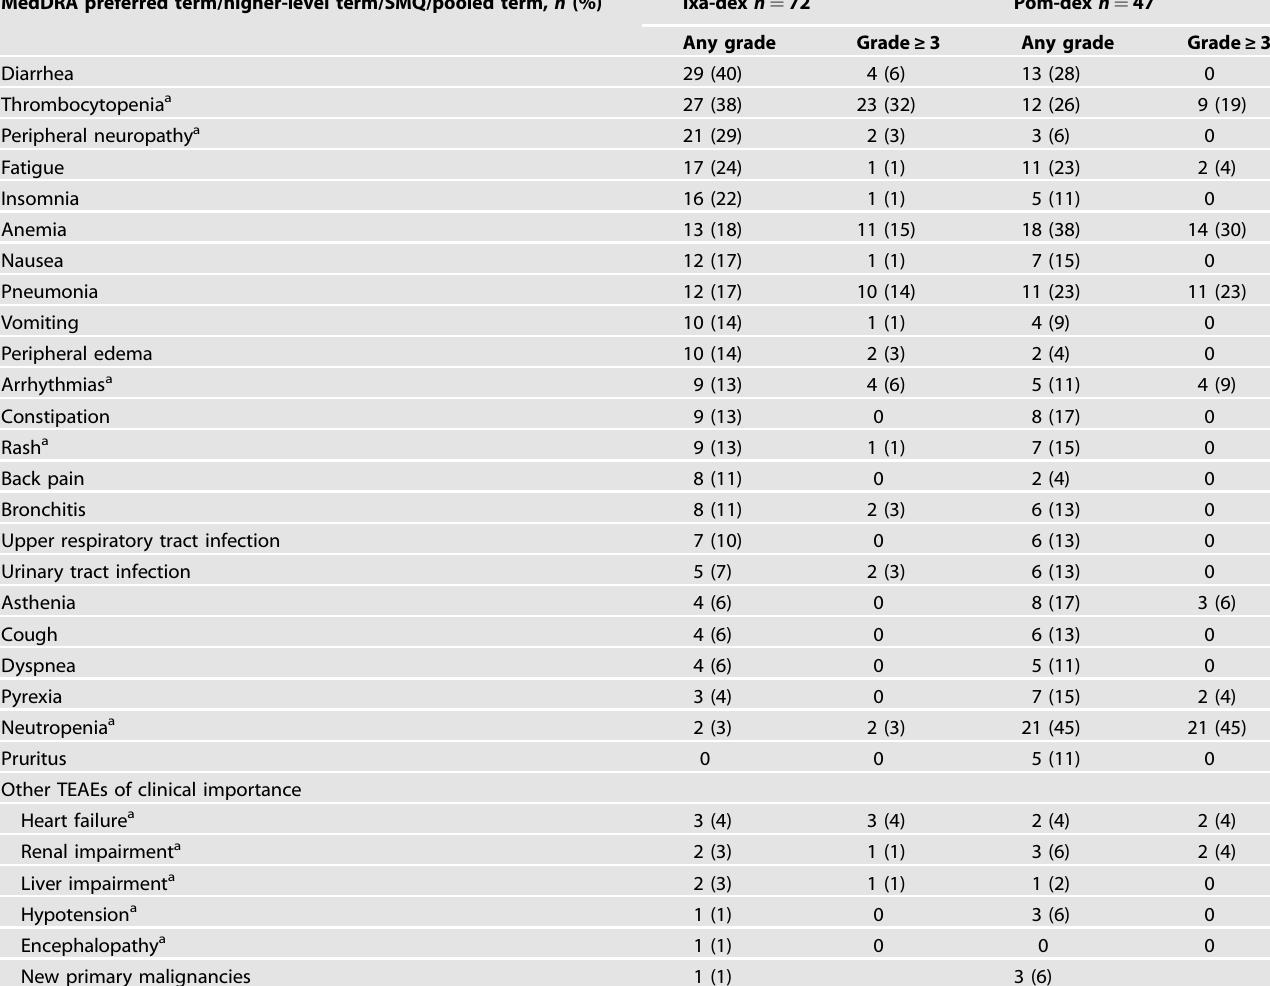
Table 4. Most common any-grade (reported in ≥ 10% of patients in either arm) and Grade ≥ 3 TEAEs (reported in ≥ 5% of patients in either arm), plus rates of additional TEAEs of clinical importance, reported with ixa-dex and pom-dex in the safety population. MedDRA preferred term/higher-level term/SMQ/pooled term, n